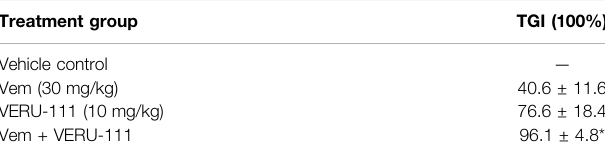
TABLE 2 | TGI comparison for in vivo combination of vemurafenib (30 mg/kg) and VERU-111 (10 mg/kg) in the Vem-resistant VR1 xenograft model. Treatment group Vehicle